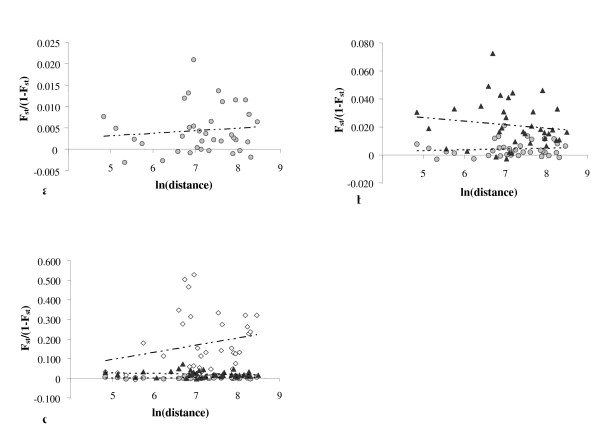
Two-dimensional isolation-by-distance plot. Representation of 9 populations from the Mediterranean region analyzed by three different markers: a) 25 X-chromosome SNPs (grey circles); b) HVRI mtDNA (black triangles) compared to X-chromosome; c) 35 Y-chromosome SNPs (empty rhombuses) compared to mtDNA and X-chromosome.